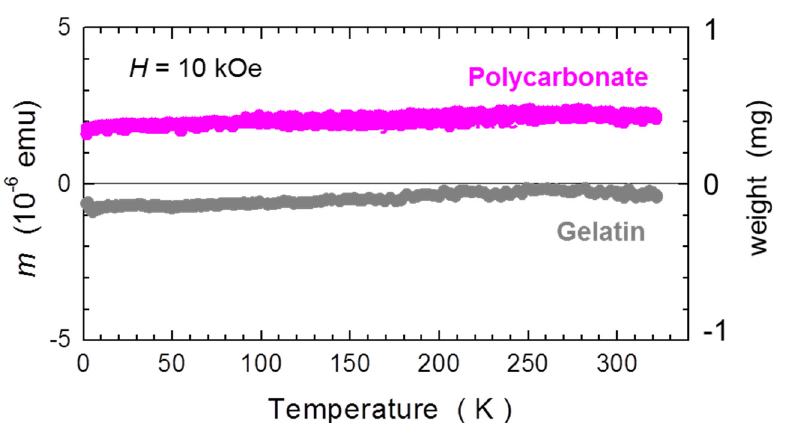
Figure 10. Temperature dependence of the magnetic moment m sensed at the location of the bottom of the central capsule for two exemplary capsule compensational sample holders assembled from gelatin (grey) and polycarbonate (magenta) capsules. Magnetic data are normalized between themselves and related to a standard mass of a 30 mg capsule. Note the complete lack of the strong low temperature upturn of m , the characteristic feature for single capsules (Figure 2).